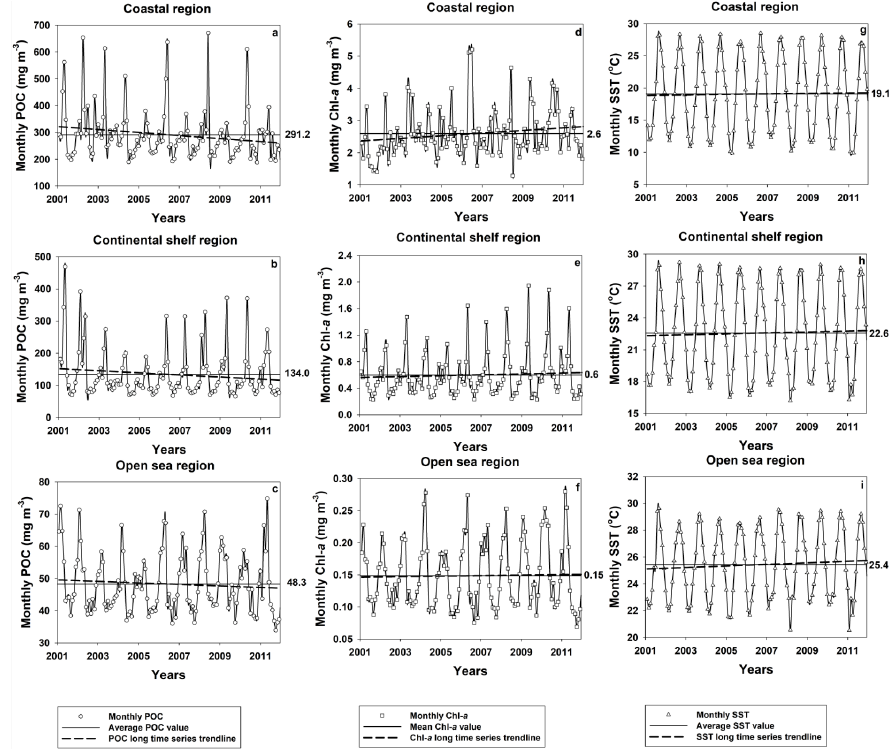
Figure 5. Time series of monthly averaged POC ( a – c ), Chl- a concentrations ( d – f ) and SST ( g – i ) in three different regions of the ECS. Bold values on the right y -axis represent the average values from 2001 to 2011. Trend lines are calculated by linear